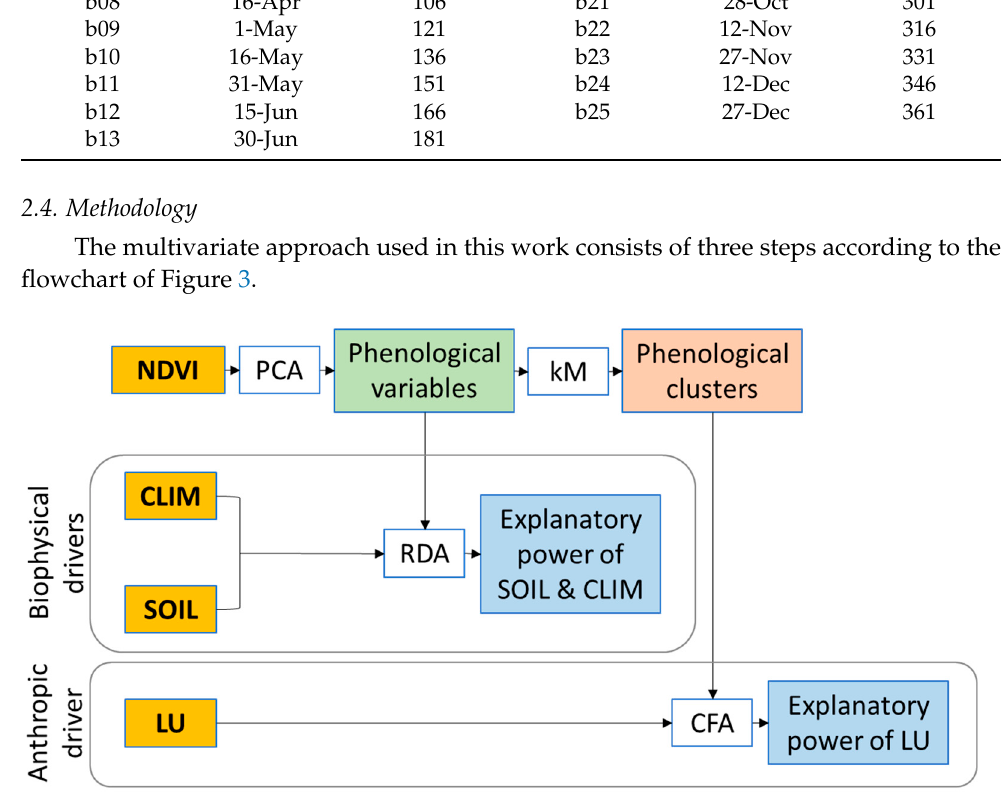
Figure 3. Flowchart of the multivariate approach used in this work.